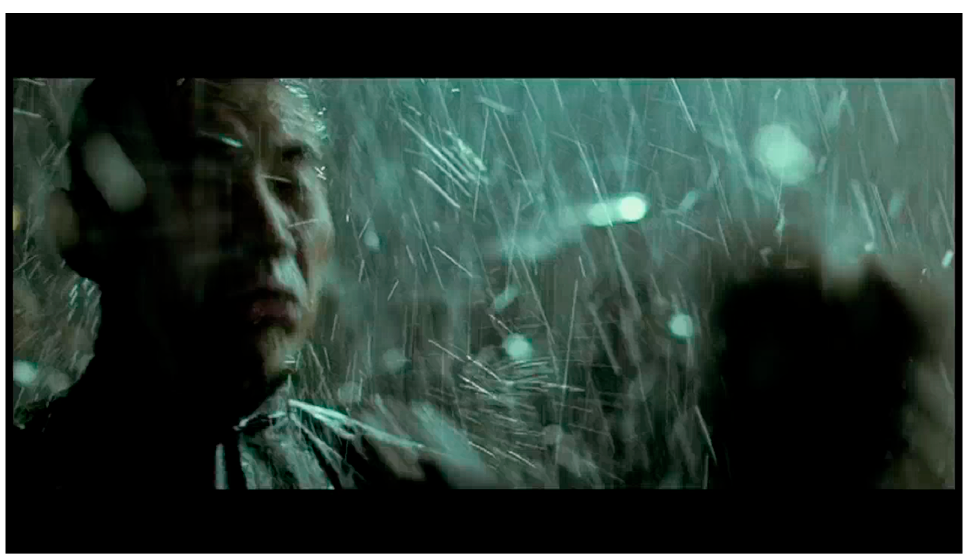
Figure 10. A web of materiality: air/space become visible, dense. Frame capture, The Grandmaster (Wong 2013).